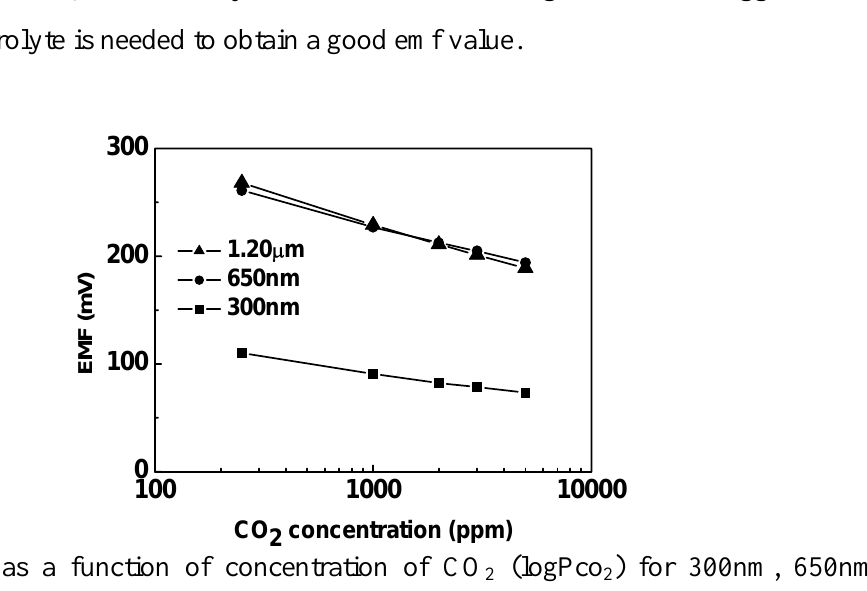
Figure 3. EMF as a function of concentration of CO thickness deposited electrolyte sensors sintered at 700 o C and operated at 500 o C temperature.